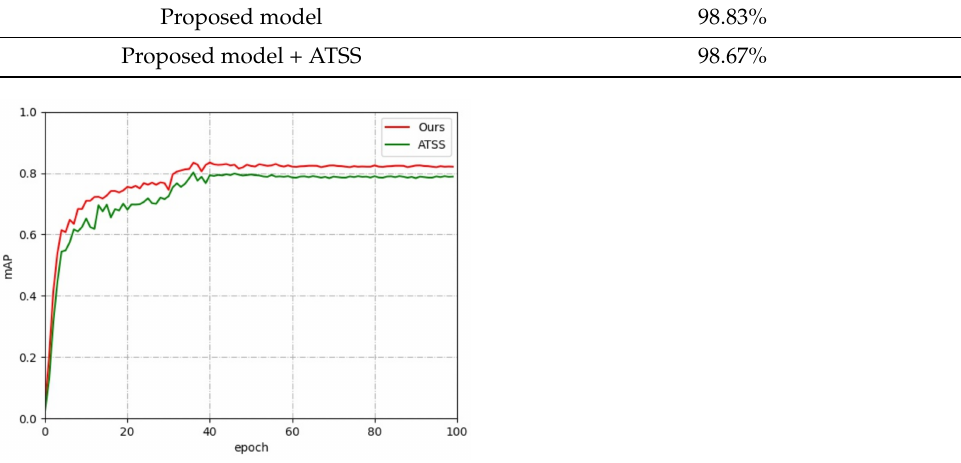
Figure 12. mAP curves of two matching strategies on public dataset.